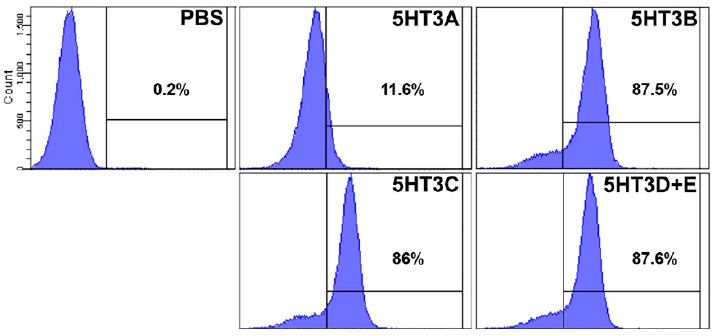
Figure A1. Flow cytometry results.